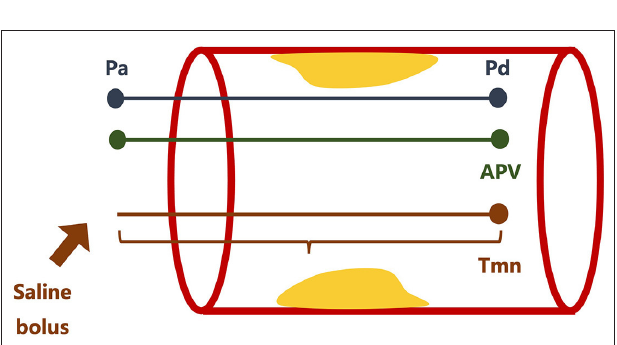
FIGURE 4 | Illustration of coronary function test. Pd, distal coronary pressure; Pa, aortic pressure; APV, average peak velocity; Tmn, transit time.